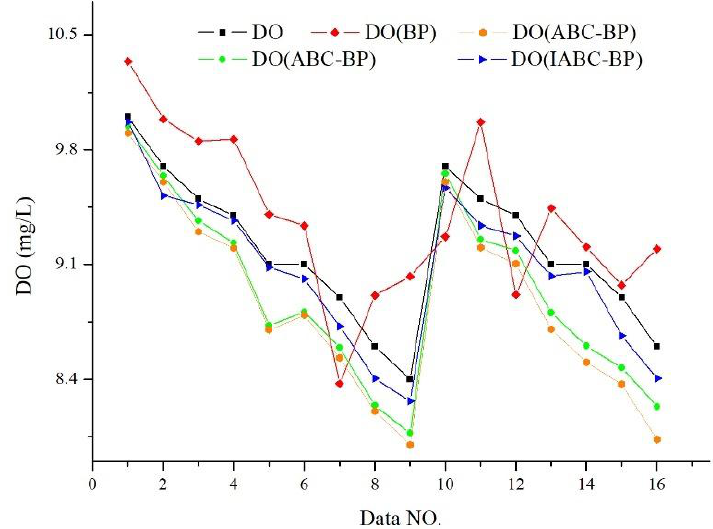
Figure 7. Comparison of DO among the four models.